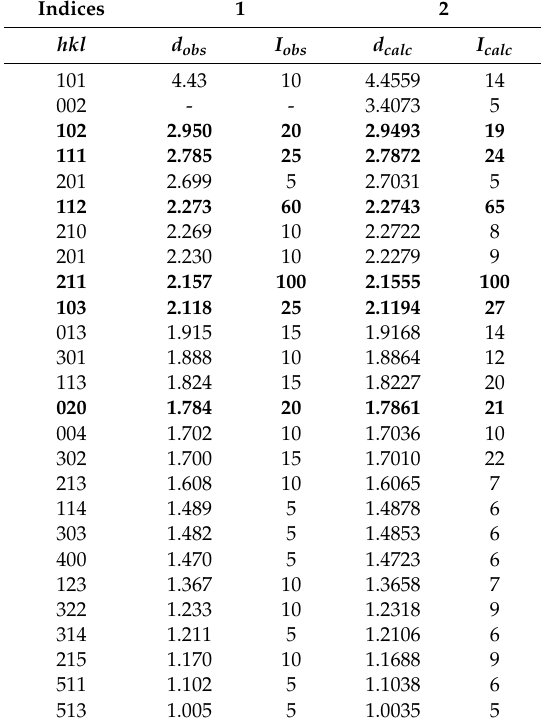
Table 5. Observed and calculated X-ray powder di ff raction data ( d in Å) for grammatikopoulosite. The strongest observed reflections are given in